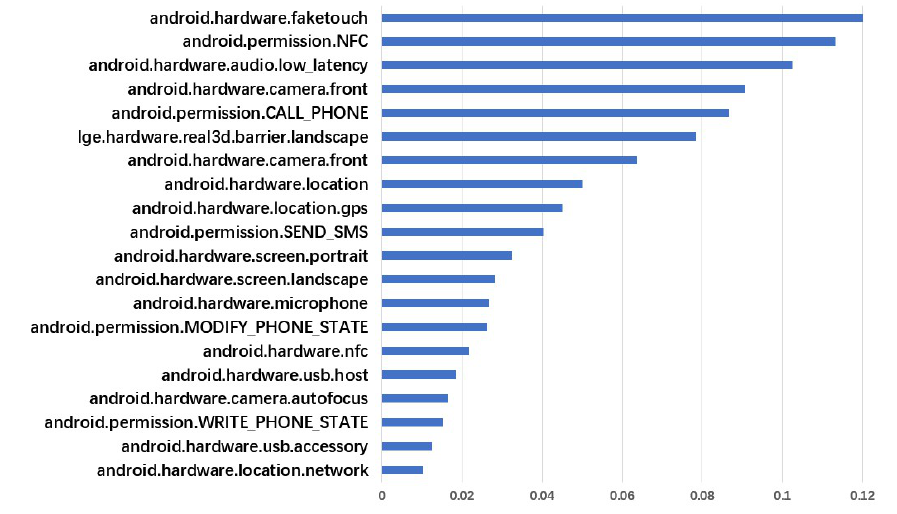
Figure 3. The most frequently added permissions in our adversarial sample generation experiments. The data is the average of 5 × 2 × 1000 samples test results.